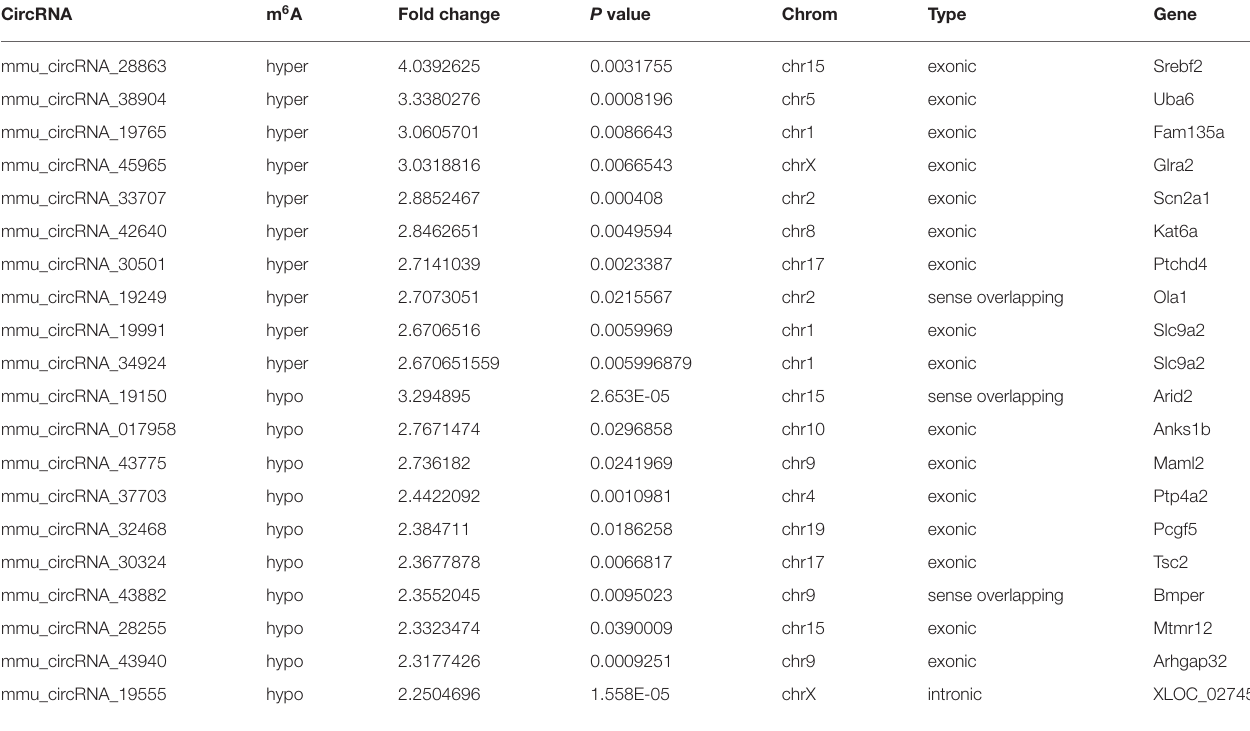
TABLE 4 | The top 10 hyper and hypo-methylated circRNAs between 7d vs. 3d.